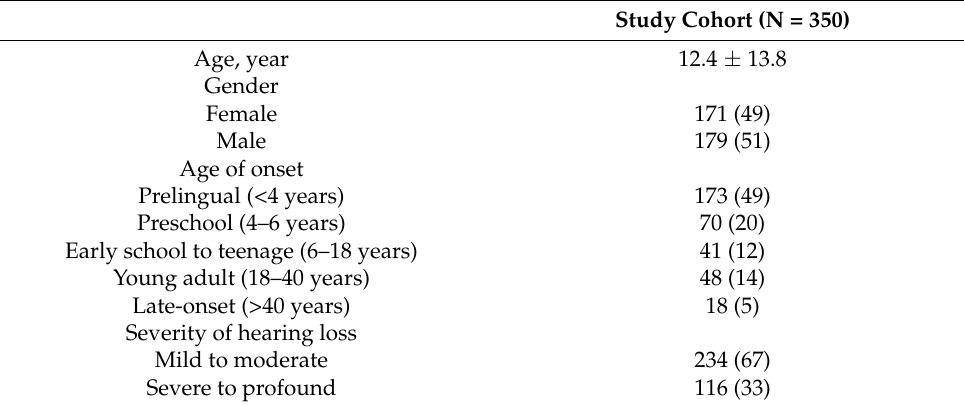
Table 2. Clinical features of the study